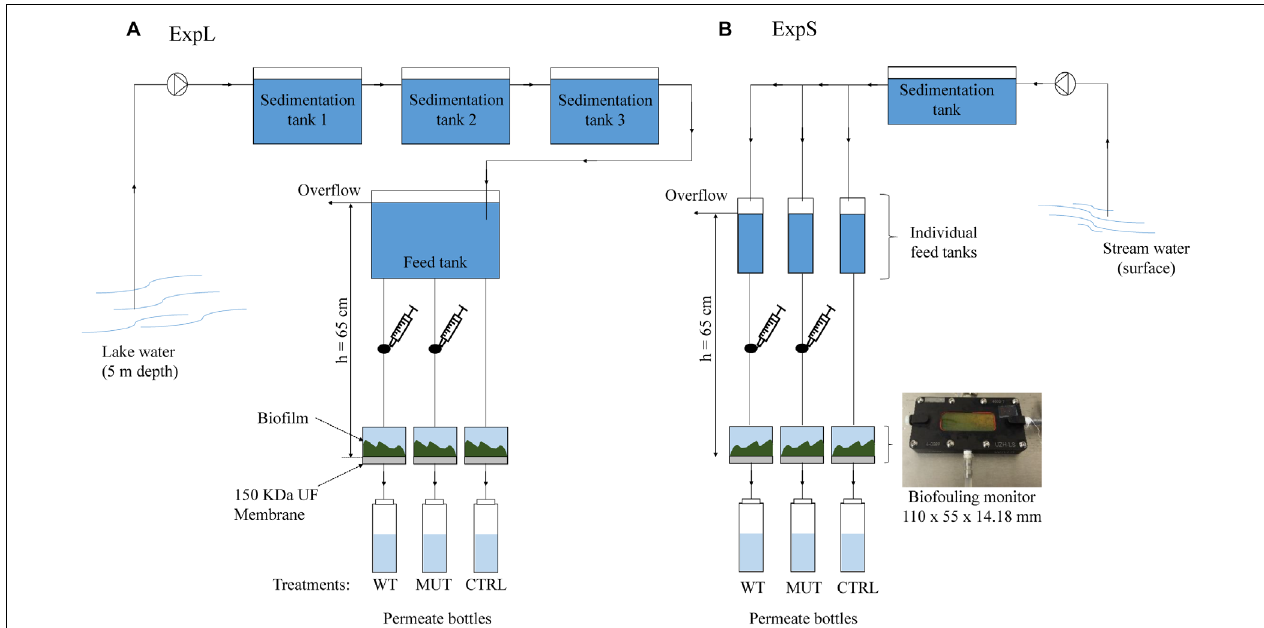
FIGURE 1 | Experimental setup of (A) the lake experiment – ExpL and (B) the stream experiment – ExpS. Each experiment consisted of three treatments: WT – addition of M. aeruginosa biomass containing 1.7 µ g MC mg − 1 DW day − 1 ; MUT – addition of biomass from the mutant M. aeruginosa strain that does not contain any MC (17 mg DW day − 1 ); and CTRL – only the respective feed water. Each treatment had three biological replicates, except for the WT biomass treatment of ExpS which had five biological replicates. The syringe connection between the feed tank and the biofouling monitor was placed in order to add the correspondent biomass for the WT and MUT biomass